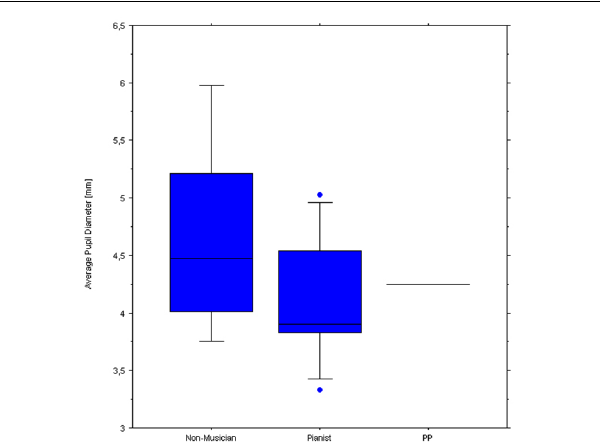
FIGURE 9 | Boxplots of pupil diameters of the Non-musicians (left) and Pianists (middle) groups. The horizontal line to the right indicates PP’s baseline average